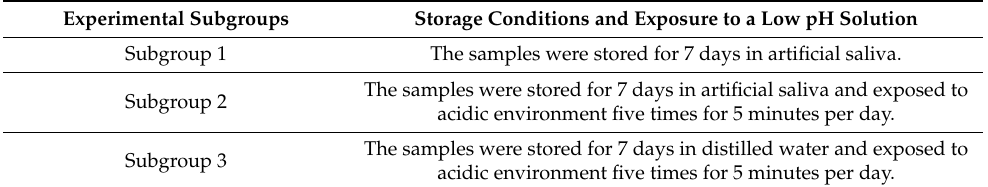
Table 1. Equia Forte HT Fil groups with and without Coat and Fuji IX Group were divided into three subgroups depending on the storage medium and exposure to a low pH